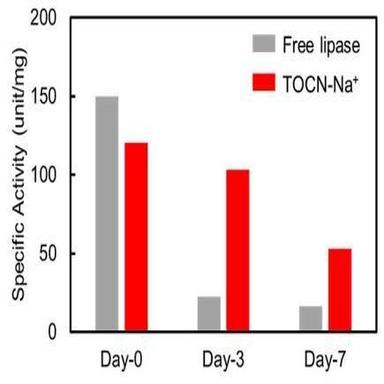
Specific activity of free lipase and lipase in TOCN-Na+ cryogels by olive oil hydrolysis after storage at 40 °C for 0, 3, and 7 days.